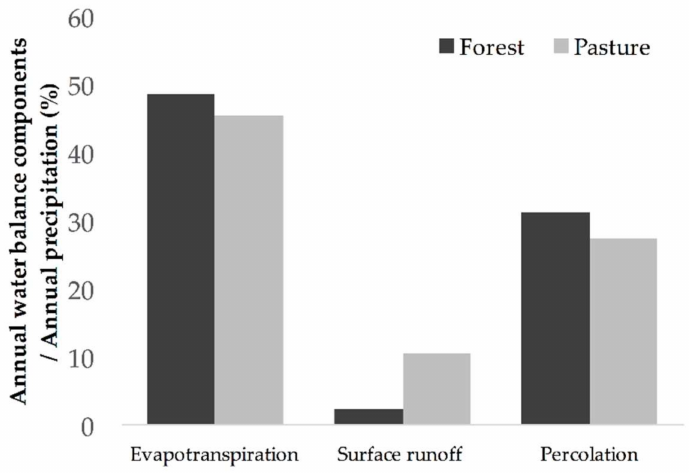
Figure 5. Components of the annual water balance in relation to average annual precipitation at the scale of hydrological response units.